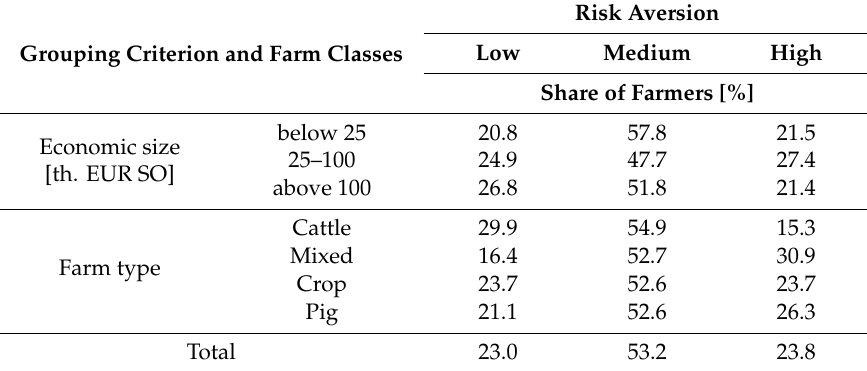
Table 3. Share of farmers according to their risk